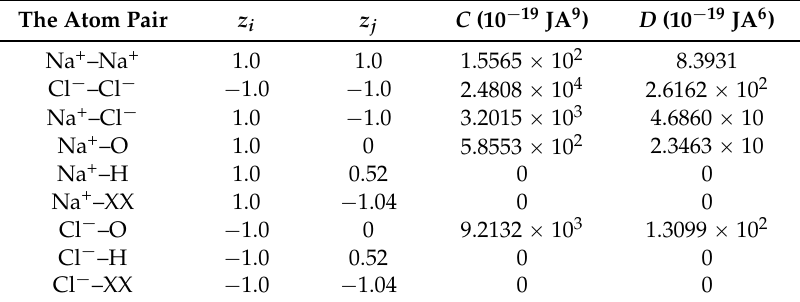
Table 8. The potential parameters between Na + , Cl ´ and TIP4P water.